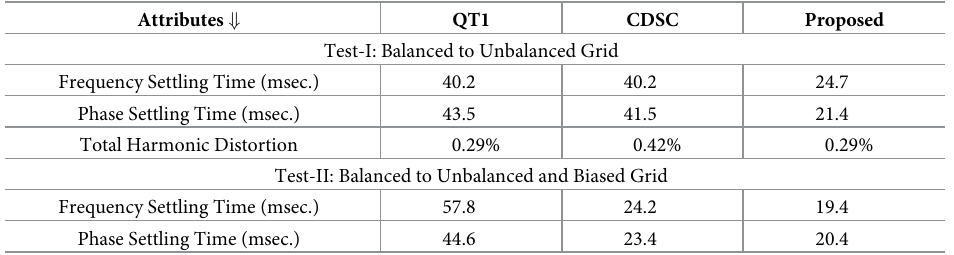
Table 2. Comparative time-domain simulation summary of the selected techniques. Attributes + QT1 CDSC Proposed Test-I: Balanced to Unbalanced Grid Frequency Settling Time (msec.) 40.2 40.2 24.7 Phase Settling Time (msec.) 43.5 41.5 21.4 Total Harmonic Distortion 0.29% 0.42% 0.29% Test-II: Balanced to Unbalanced and Biased Grid Frequency Settling Time (msec.) 57.8 24.2 19.4 Phase Settling Time